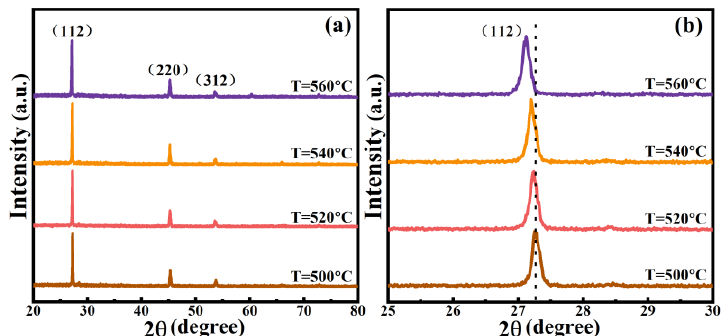
Figure 2. ( a ) XRD patterns of the CNZTSSe films selenized at 500 °C, 520 °C, 540 °C, and 560 °C; ( b ) enlarged images of (112) peaks of all films.